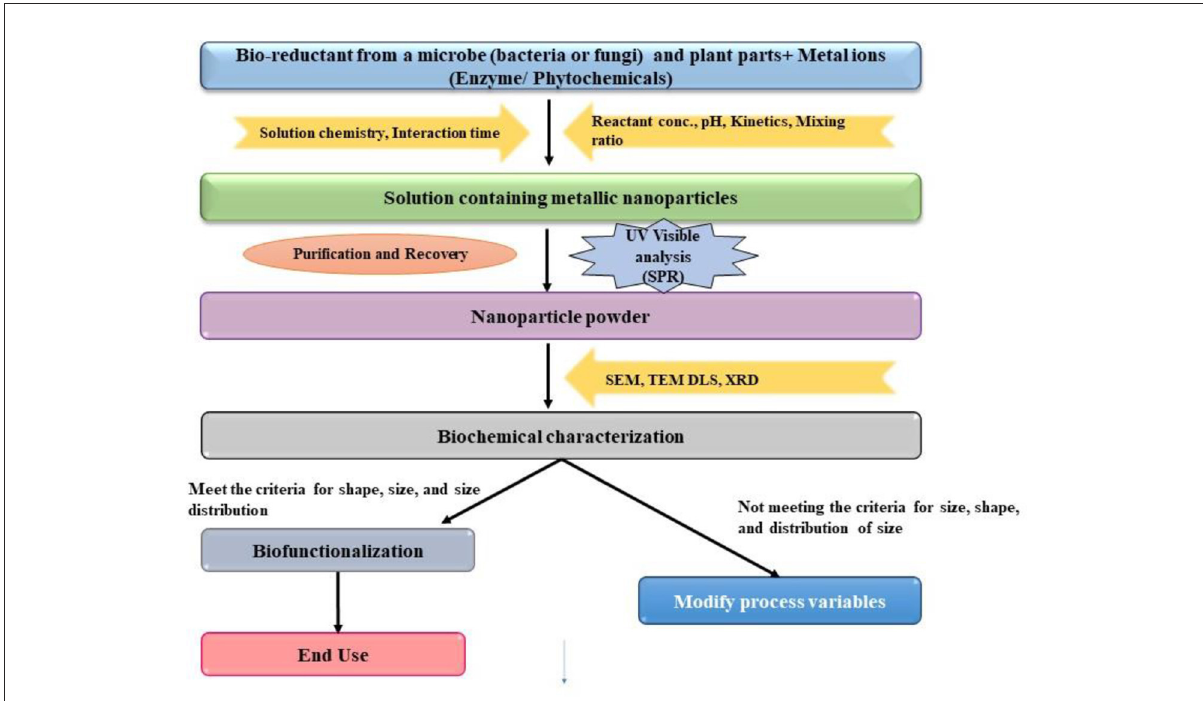
FIGURE3 Biosynthesis of microbe-based nanoparticles. SPR, surface plasmon resonance; SEM, scanning electron microscopy; TEM, transmission electron microscopy; DLS, dynamic light scattering; XRD, X-Ray diffraction